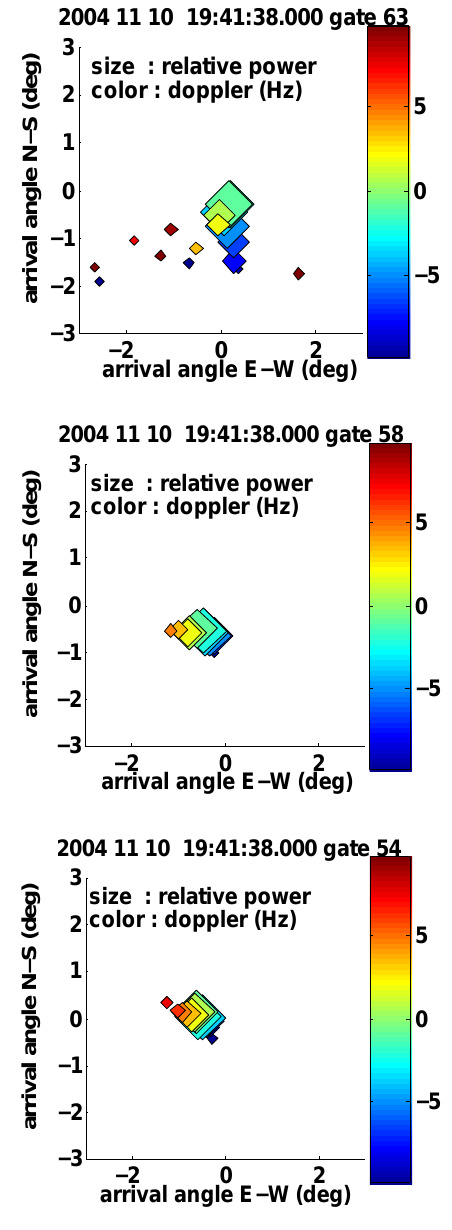
Fig. 11. Examples of arrival angle maps for ESRAD observations at the top (a) , maximum (b) and base (c) of the PMWE layer. Ex- amples are from averaged cross-spectra between 19:36–19:42 UT. Each coloured square is plotted at the angular position from which the echo arrives (from the phase of the cross-spectra between East- West and North-South antenna-segment pairs, respectively) . The colour shading indicates the Doppler shift corresponding to the par- ticular frequency bin and the area of the square is proportional to the cross-spectral power from the North-South antenna-segment pairs. Points are plotted for all frequencies where the spectral power is at least half of the